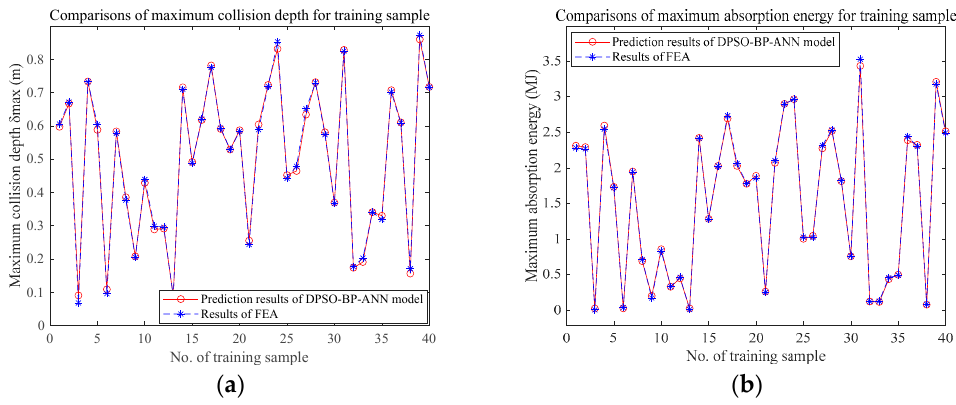
Figure 7. Comparisons for training sample. ( a ) Comparisons of maximum collision depth, ( b ) comparisons of maximum absorption energy.